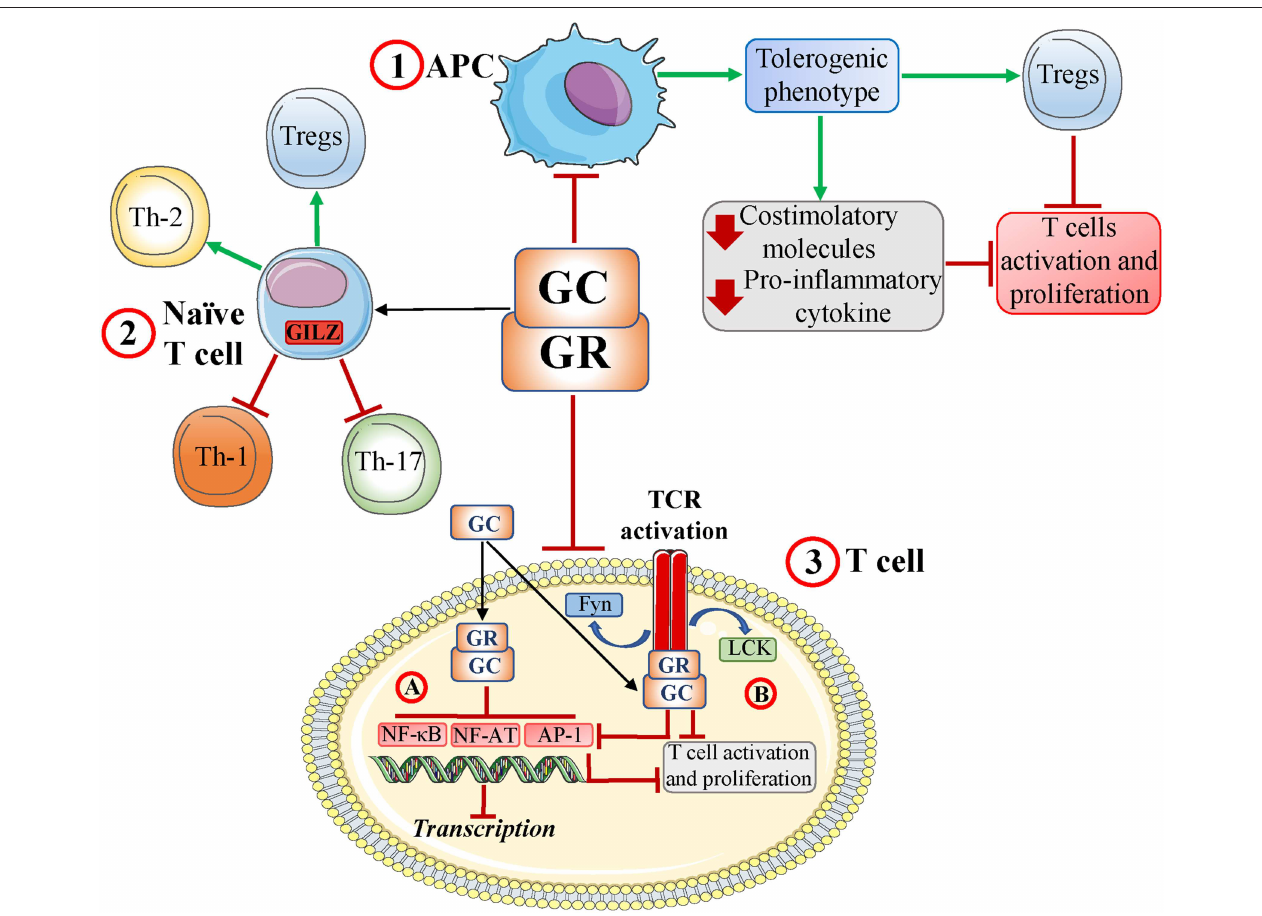
FIGURE 1 | Glucocorticoids and the T-cell response. Glucocorticoid ( GCs) and glucocorticoid receptor (GR) interactions induce: (1) a tolerogenic antigen-presenting cell (APC) phenotype with decreased production of both proinflammatory chemokines and costimulatory molecules and development of regulatory T cells (Tregs). This subsequently inhibits T-cell activation; (2) a modulation of naïve T-cell differentiation, including inhibition of Th-1 and Th-17 cell development and induction of Th-2 cells and Tregs; and (3) inhibition of T-cell receptor (TCR) signaling by inhibiting (genomic effects) key transcription factors such as NF-AT, AP-1, and NF- κ B (3A) and disruption of TCR-associated multiprotein complexes containing GR, LCK, and FYN (rapid, non-genomic effects) with inhibition of NF-AT, AP-1, and NF- κ B (3B). Ultimately, these interactions impair TCR signaling and T-cell activation/proliferation. Red T-headed leaders indicate inhibition; green arrow-headed leaders indicate